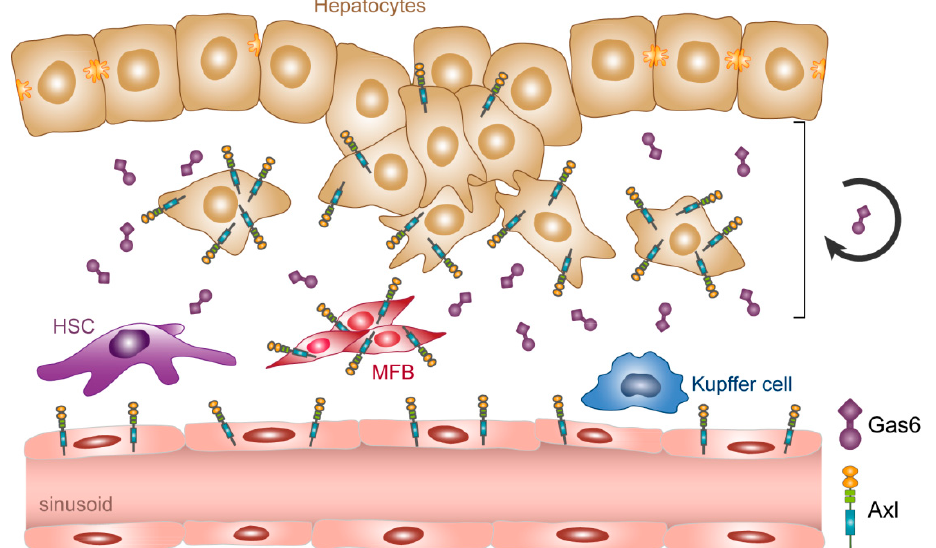
Figure 3. Expression of Gas6 and Axl in hepatocellular carcinoma (HCC). Malignant hepatocytes undergoing de-differentiation by EMT as well as HSCs trans-differentiating to MFBs upregulate Axl expression. EMT-transformed hepatocytes secrete Gas6 causing autocrine Gas6/Axl signaling. Activated HSCs/MFBs and Kupffer cells release Gas6 into the tumor microenvironment (TME). Circled arrow indicates autocrine Gas6/Axl signaling. HSC, hepatic stellate cell; MFB, myofibroblast.